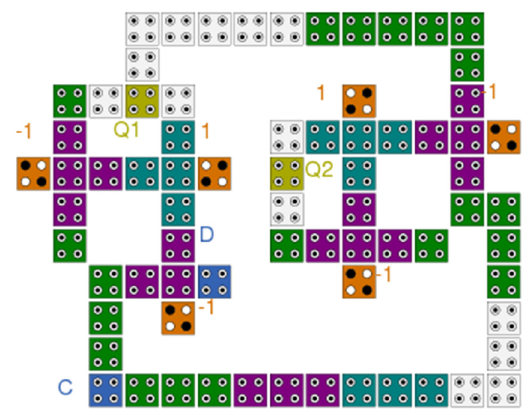
Figure 15. Block diagram representation of SIPO shift register.